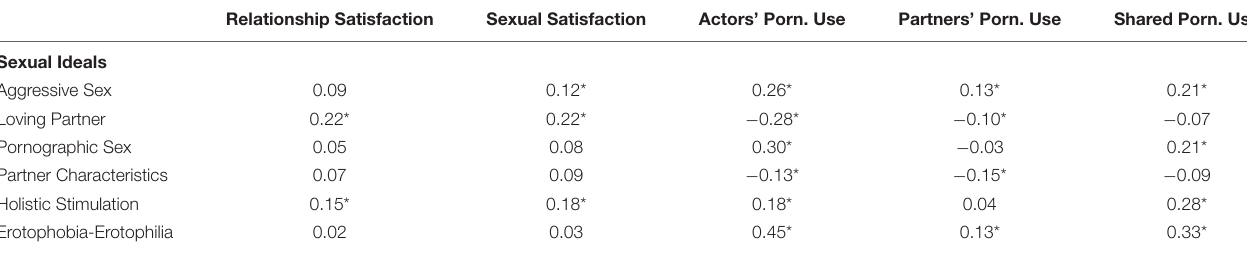
TABLE 7 | Correlations between primary variables and potential “third variables” for Study 3 ( N = 207 couples). Relationship Satisfaction Sexual Satisfaction Actors’ Porn. Use Partners’ Porn. Use Shared Porn.